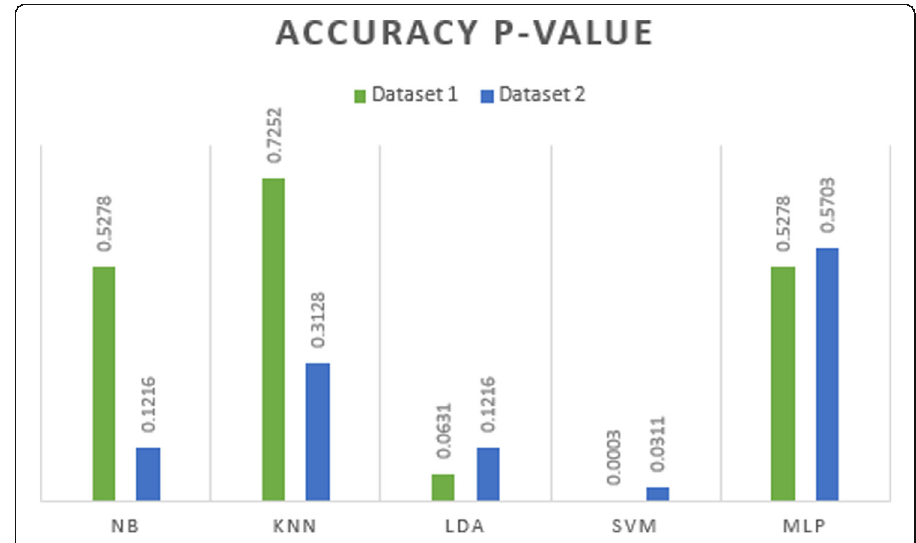
Fig. 9 Visualizing Dataset1 using Traditional Dendrogram